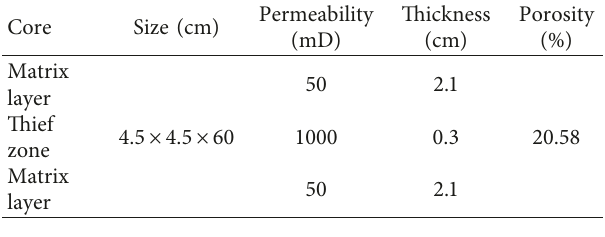
Thief zone 0.3cm MB Figure 2: The experimental model of the thief zone. Table 1: Core parameters of the water flooding test with the thief zone in the middle of MB.